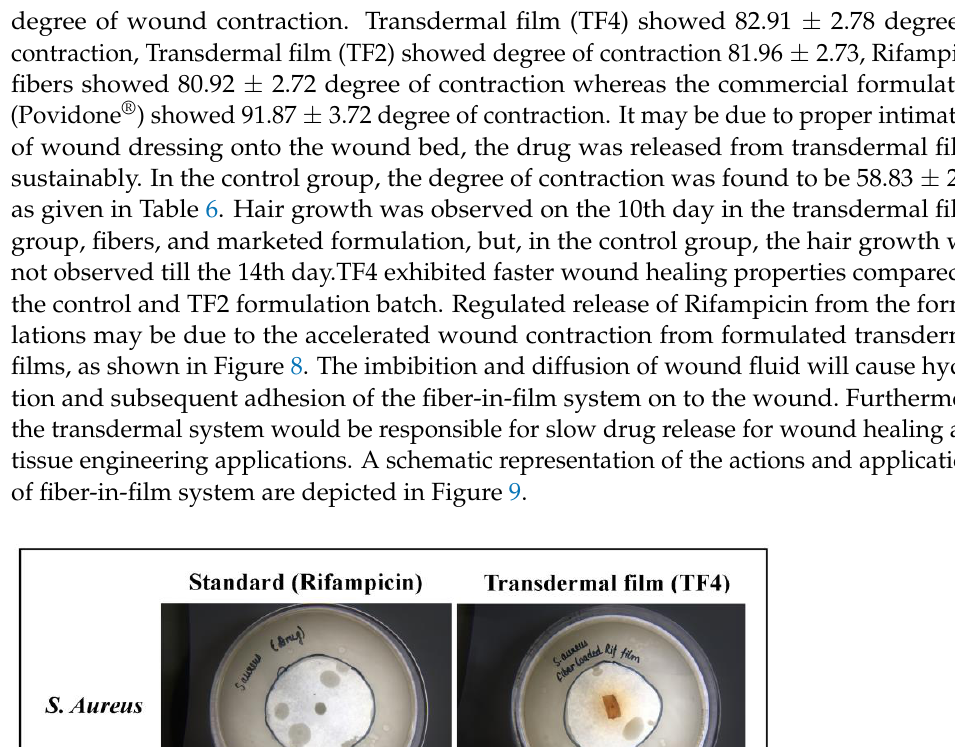
Figure 9. Scheme representing the actions and applications of fiber-in-film system. 6. Remarks and Conclusions A suitable analytical method of rifampicin was developed by UVVisible spectropho- tometer and in a mixture of phosphate buffer (pH 7.4) and ethanol (50:50, v/v ), rifampicin showed maximum absorption at a wavelength of 337 nm. The formulation developed was characterized by various techniques such as SEM, XRD, and FTIR, and resulted as absence of interaction between drug and polymeric matrix. The kinetic study was executed and fitted into various kinetic models where n value depicted anomalous behavior of all for-